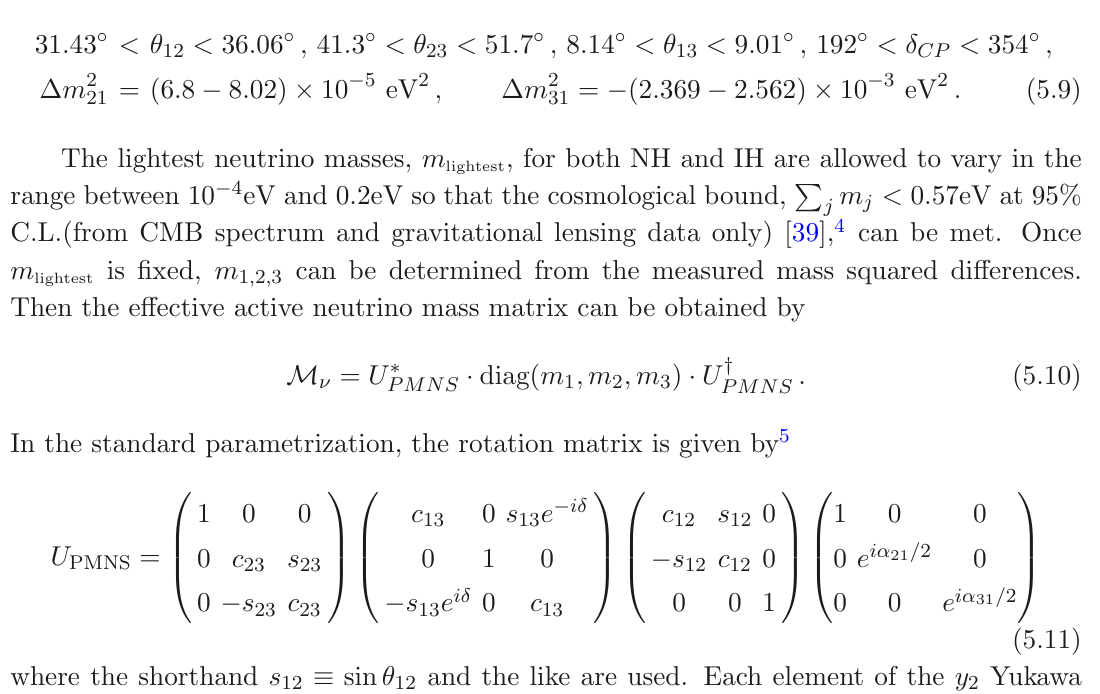
Figure 2 . Feynman diagrams for µ eγ transition, the photon can attach to any charged line. → As for the IH case, the corresponding 3 σ ranges